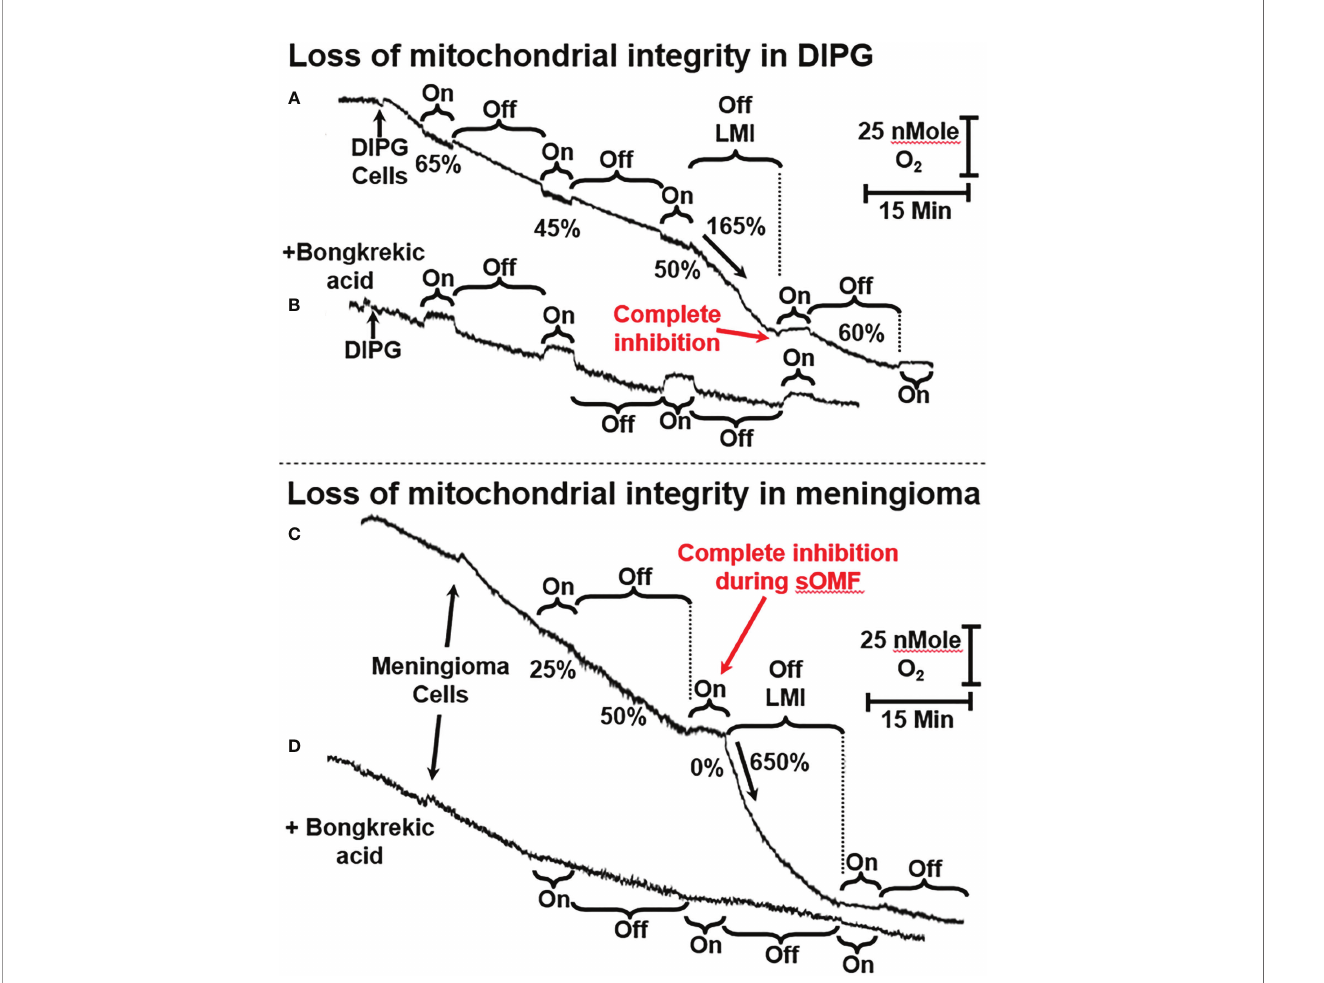
FIGURE 4 | sOMF stimulation ofprimary DIPG and meningioma cells. (A) Mitochondria of primary DIPG cells undergo MPT after repeated cycles of magneticstimulation, resulting frominhibition of fl ux and mild uncoupling. (B) MPT is blocked by bongkrekic acid in the paired control trace. (C) Mitochondria of primarymeningioma cells undergo MPT after repeated cycles of magnetic stimulation,resulting from inhibition of fl uxand mild uncoupling. (D) MPT isblocked bybongkrekic acid in the paired control